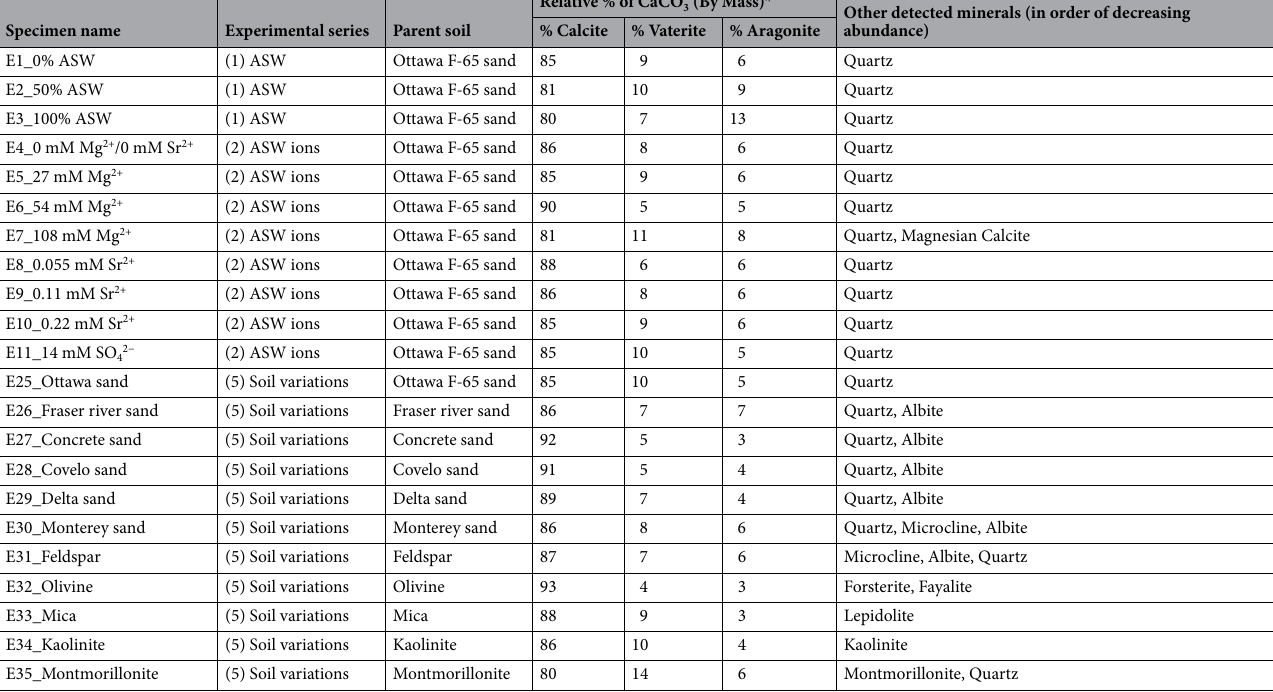
Table 3. Summary of X-ray diffraction (XRD) S-Q analysis results for all precipitates. *XRD S-Q analyses have an estimated error of ± 5% by mass following other independent